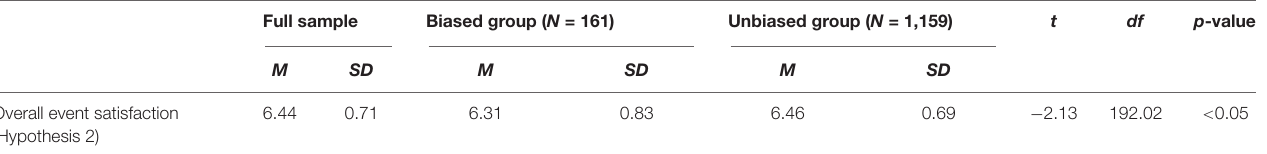
TABLE 7 | Results of independent sample t -test with unequal variance